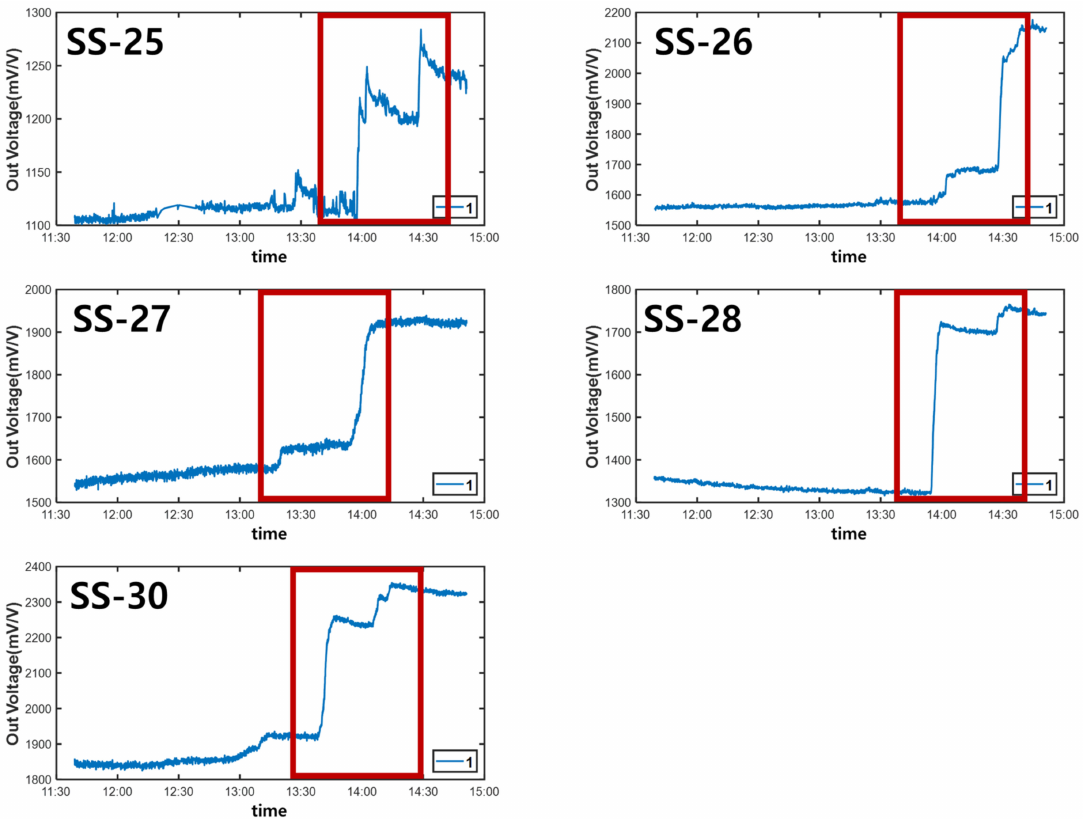
Figure 26. Monitoring data graphs for